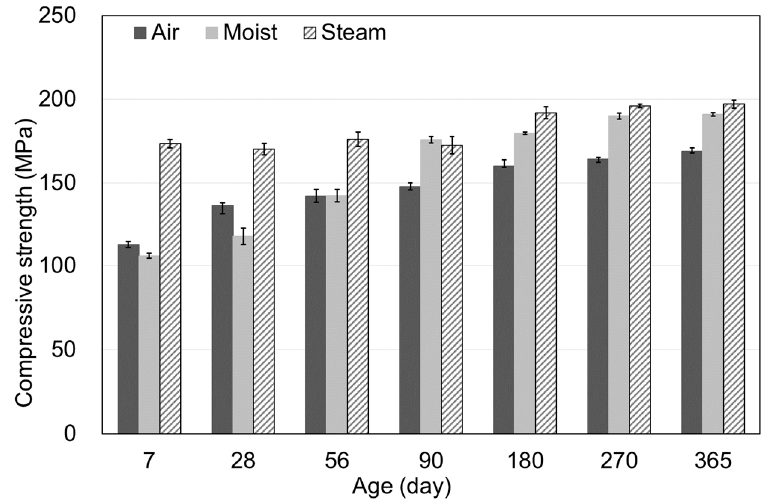
Figure 3. Compressive strength according to curing methods.